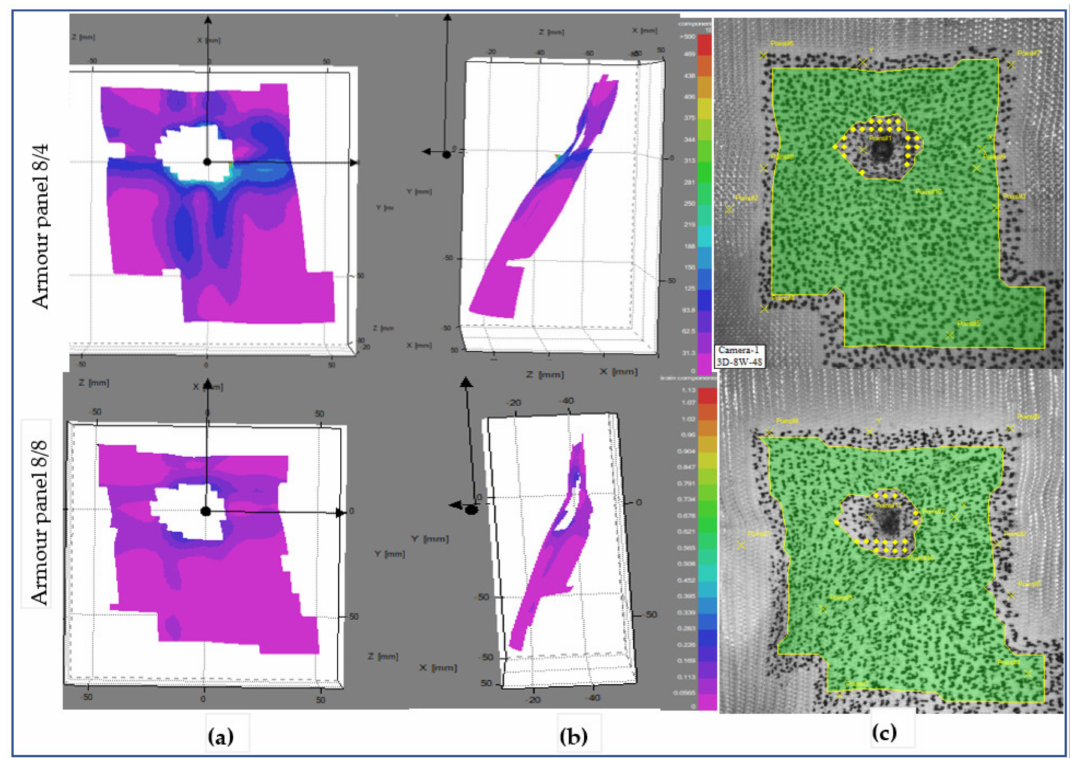
Figure 13. Surface displacement of frontal armour panel at impact times of 0.18 ms ( a ), ( b ) 3D frontal and side views of stereoscopic images respectively, and ( c ) frontal panel images at shot point 1.